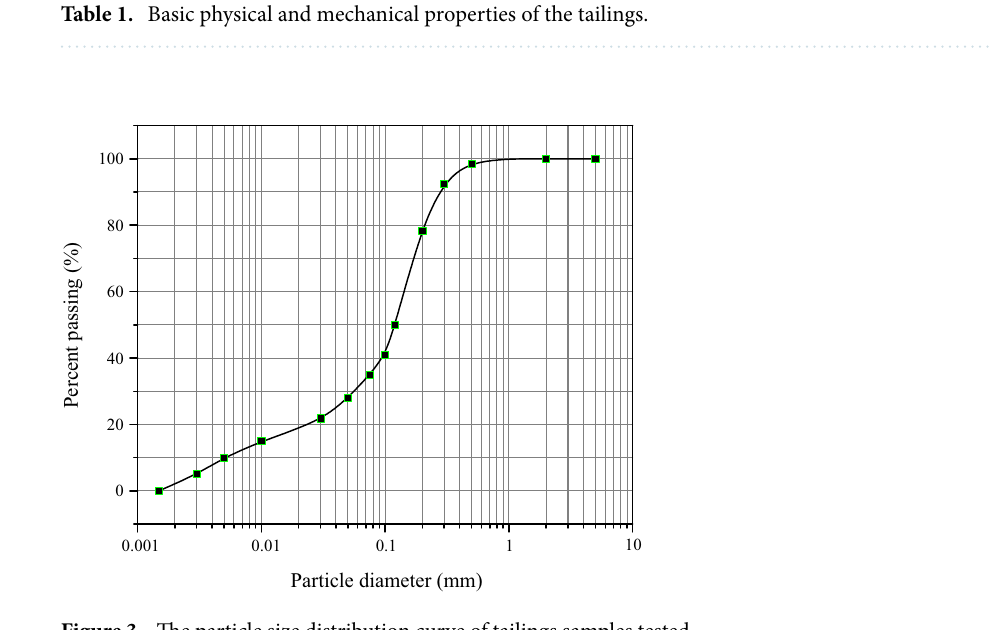
Figure 3. The particle size distribution curve of tailings samples